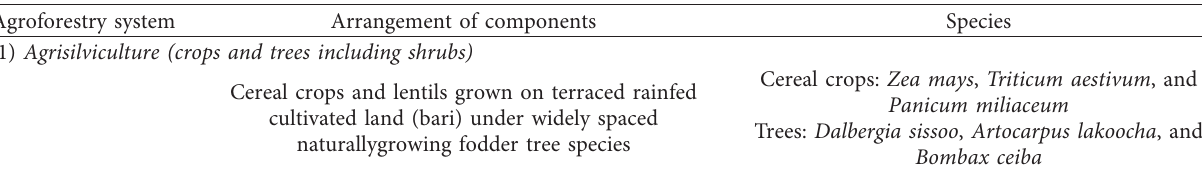
Table 1: Characteristics of agroforestry systems in the study area.